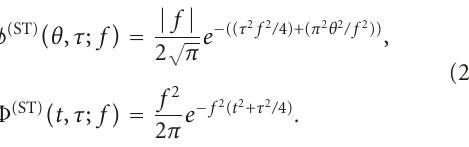
a window function ψ ( t ) can be expressed by the extended Cohen’s class representation